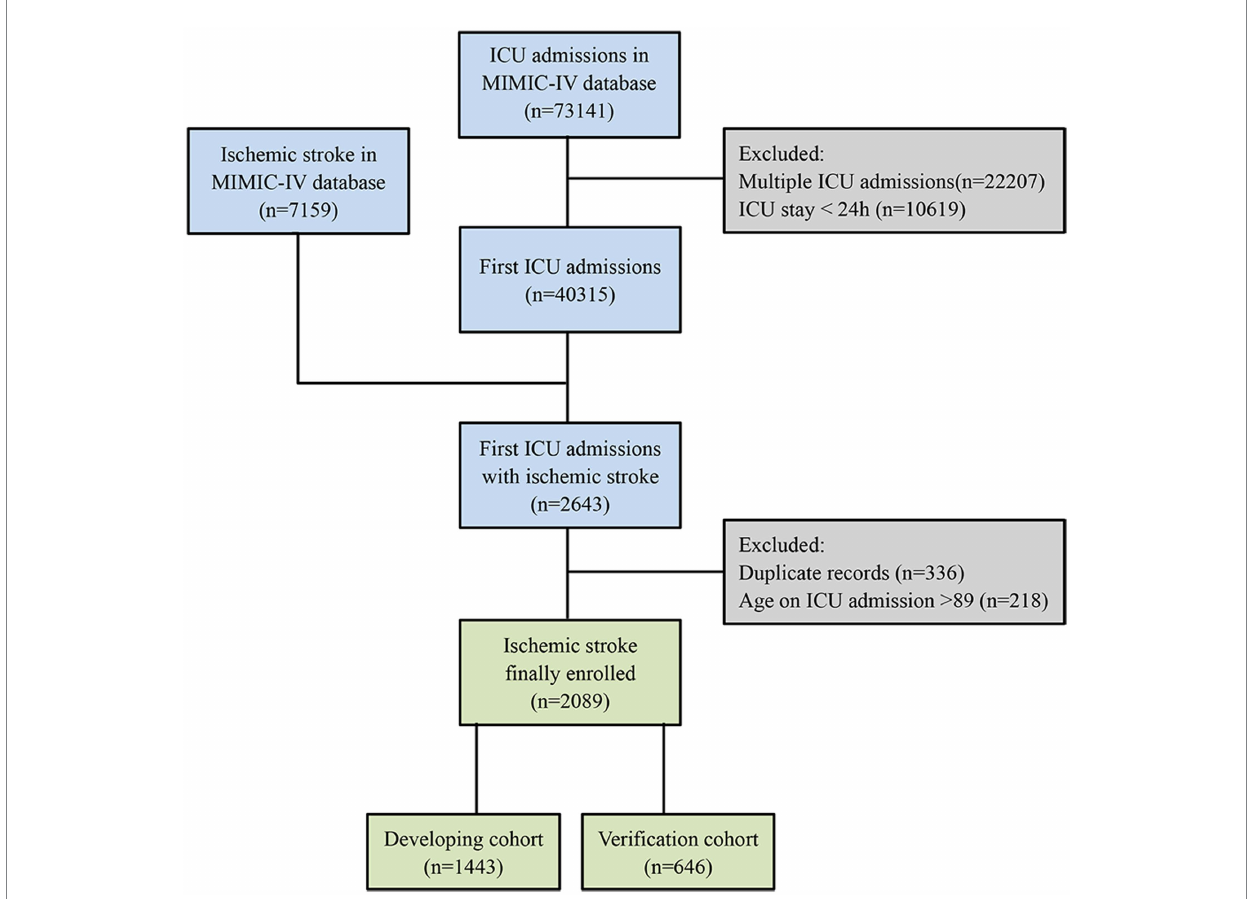
FIGURE 1 Flow chart of the patient selection process. MIMIC-IV, medical information mart for intensive care IV; ICU, intensive care